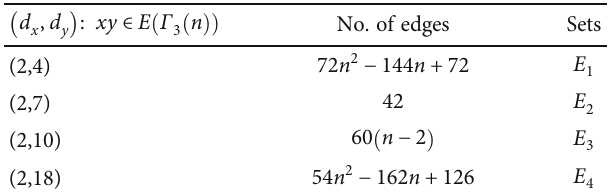
n Þ with respect to degree of end 3 ð